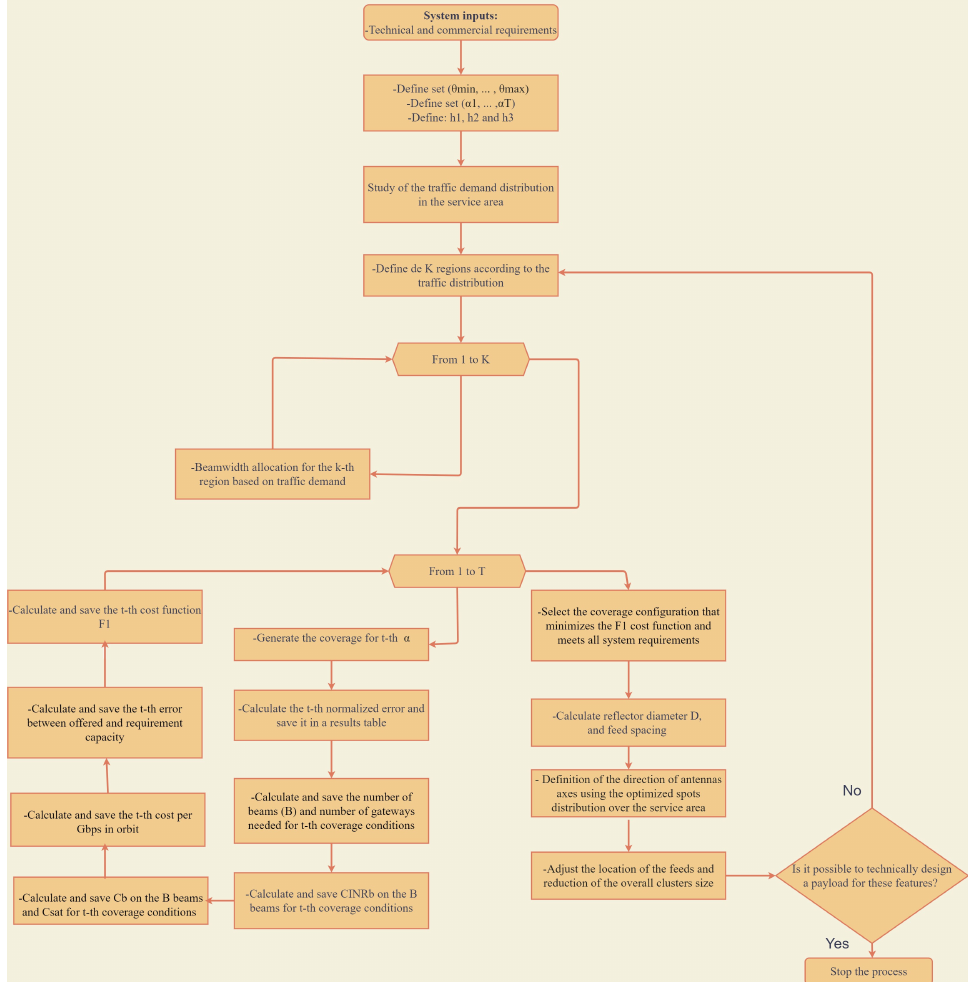
Figure 9. Flowchart of the methodology of multibeam satellite design for irregular beams